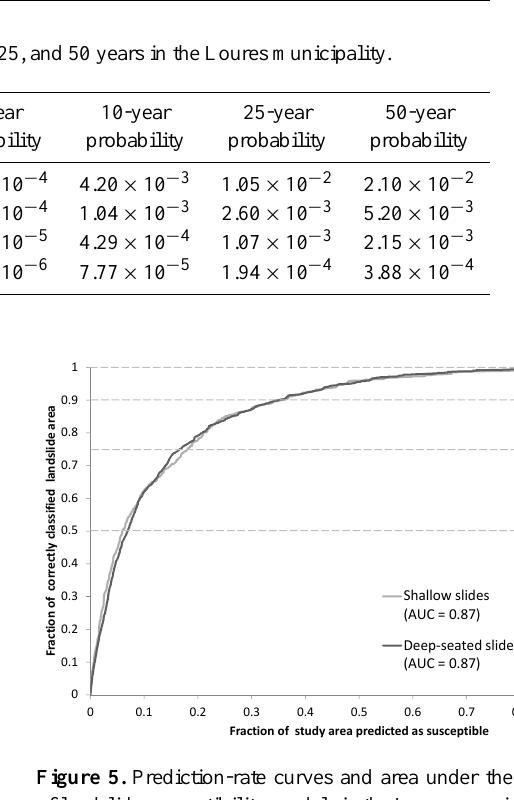
Figure 5. Prediction-rate curves and area under the curve (AUC) of landslide susceptibility models in the Loures municipality (based on the work done by Guillard and Zêzere,